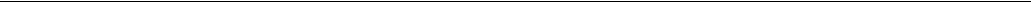
browser excerpts showing examples of H3K27me3- (gray, vertical scale 0 – 100 RPKM), H3K4me3- (red, vertical scale 0 – 160 RPKM), and H3K9me3 for Th , Lmx1a , Nr4a2 , and Foxa2 in mDA and SER neurons, respectively. k Chromatin-state transitions between SER and mDA neurons for downregulated genes in mDA relative to SER as in f . l – o Left: UCSC Genome browser excerpts showing examples of enrichment of H3K27me3 (gray, vertical scale 0 – 100 RPKM), H3K4me3 (red, vertical scale 0 – 160 RPKM), and H3K9me3 (blue, vertical scale 0 – 80 RPKM) around the Tph2 , Htr1a , Gata2, and Gata3 loci. Each plot spans 20 kb. Right: Bars indicate average RPKM ± SD for Tph2 , Htr1a , Gata2, and Gata3 in mDA and SER neurons,